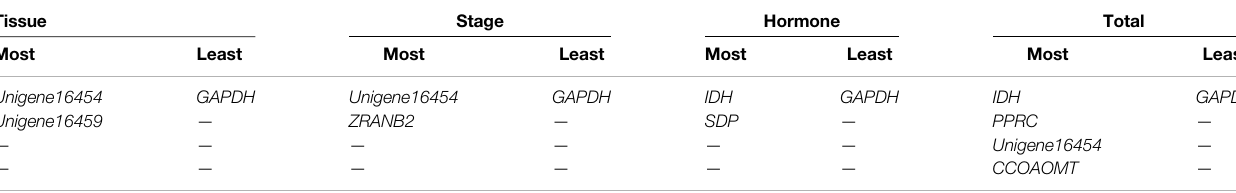
— — — — — — — — — — — — — CCOAOMT — Tissue represents samples from different tissues. Stage represents samples from chimeric leaves at different developmental stages. Hormone represents samples from tissue culture plantletunderdifferenthormonetreatments.Totalrepresentssamplesfromtheabovethreeexperimentalconditions.Mostandleastrepresentthemoststablereferencegeneandtheleast stable reference gene, respectively.